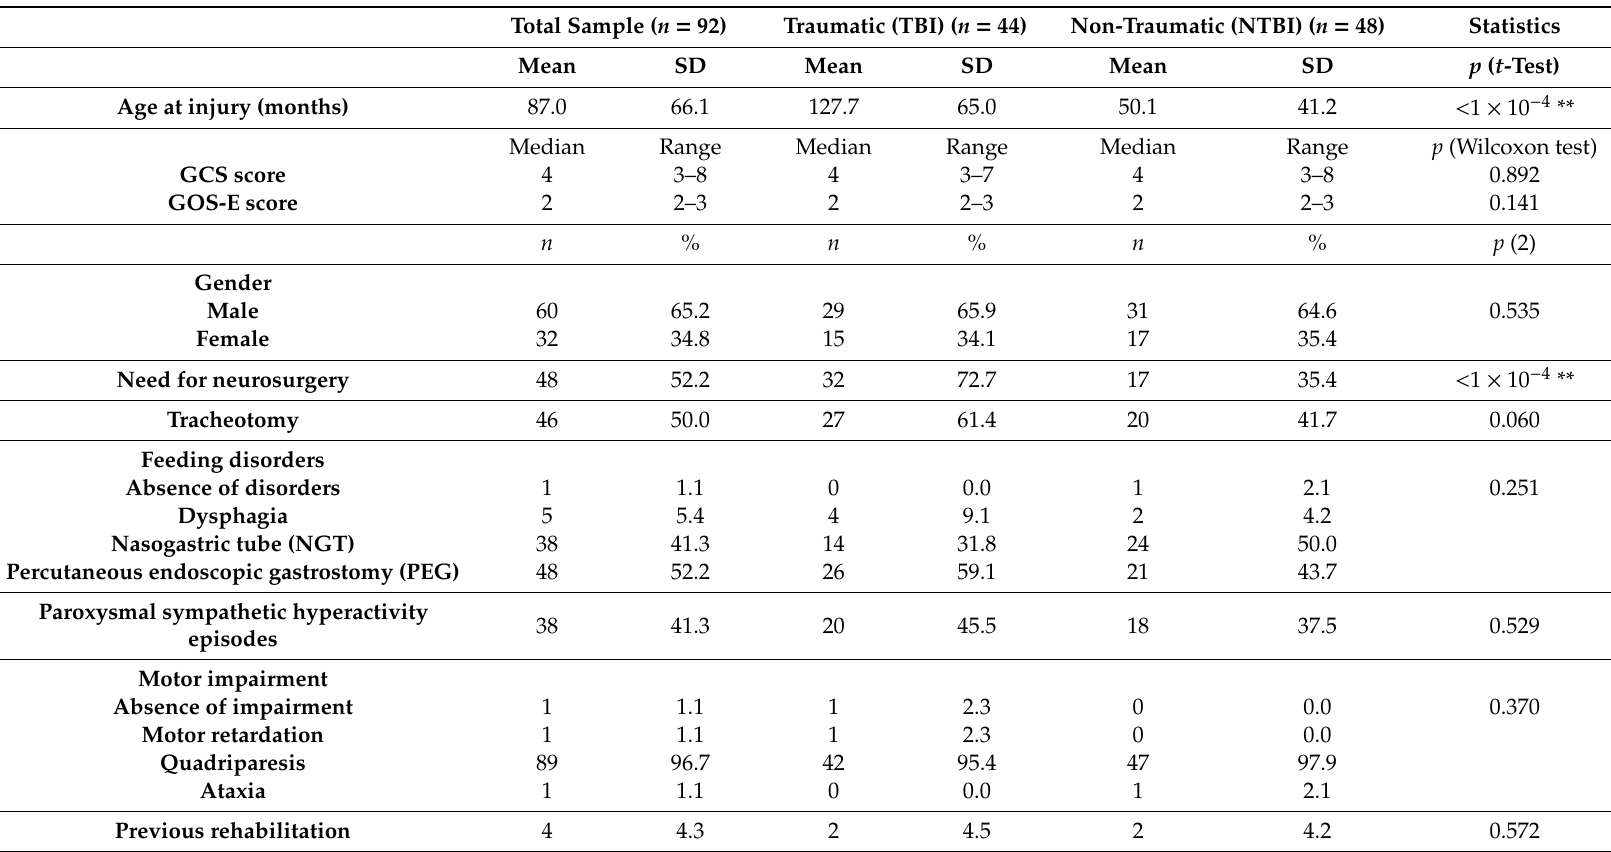
Table 2. Clinical and demographic characteristics of the total sample and the two groups divided by etiology. SD: standard deviation; GCS: Glasgow Coma Scale; GOS-E: Glasgow Outcome Scale